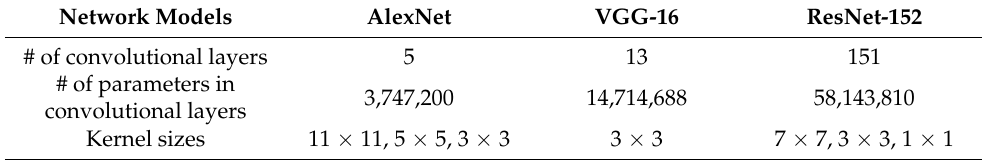
Table 1. Summary of the CNN models